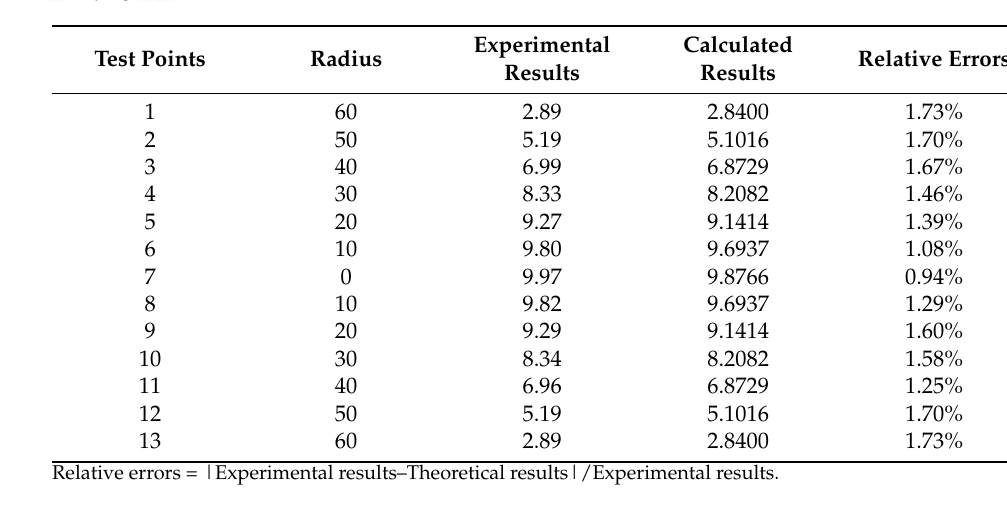
Experimental and theoretical values of deflection and their relative errors when H = 97.5 mm.